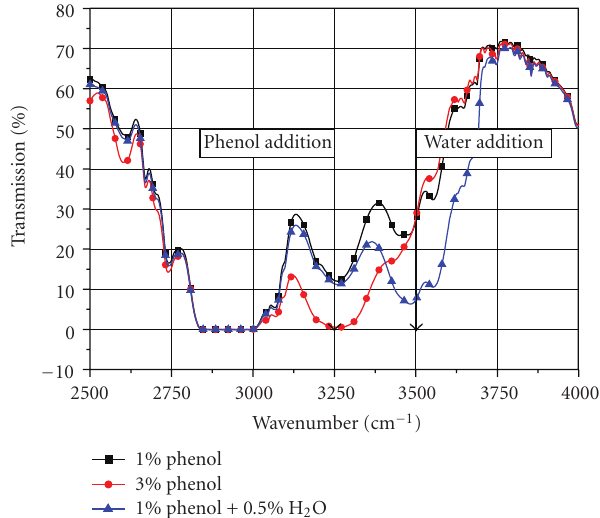
Figure 4: IR transmission of Skydrol LD-4 with di ff erent additions of phenol and a mixture of phenol and water. Optical path length: